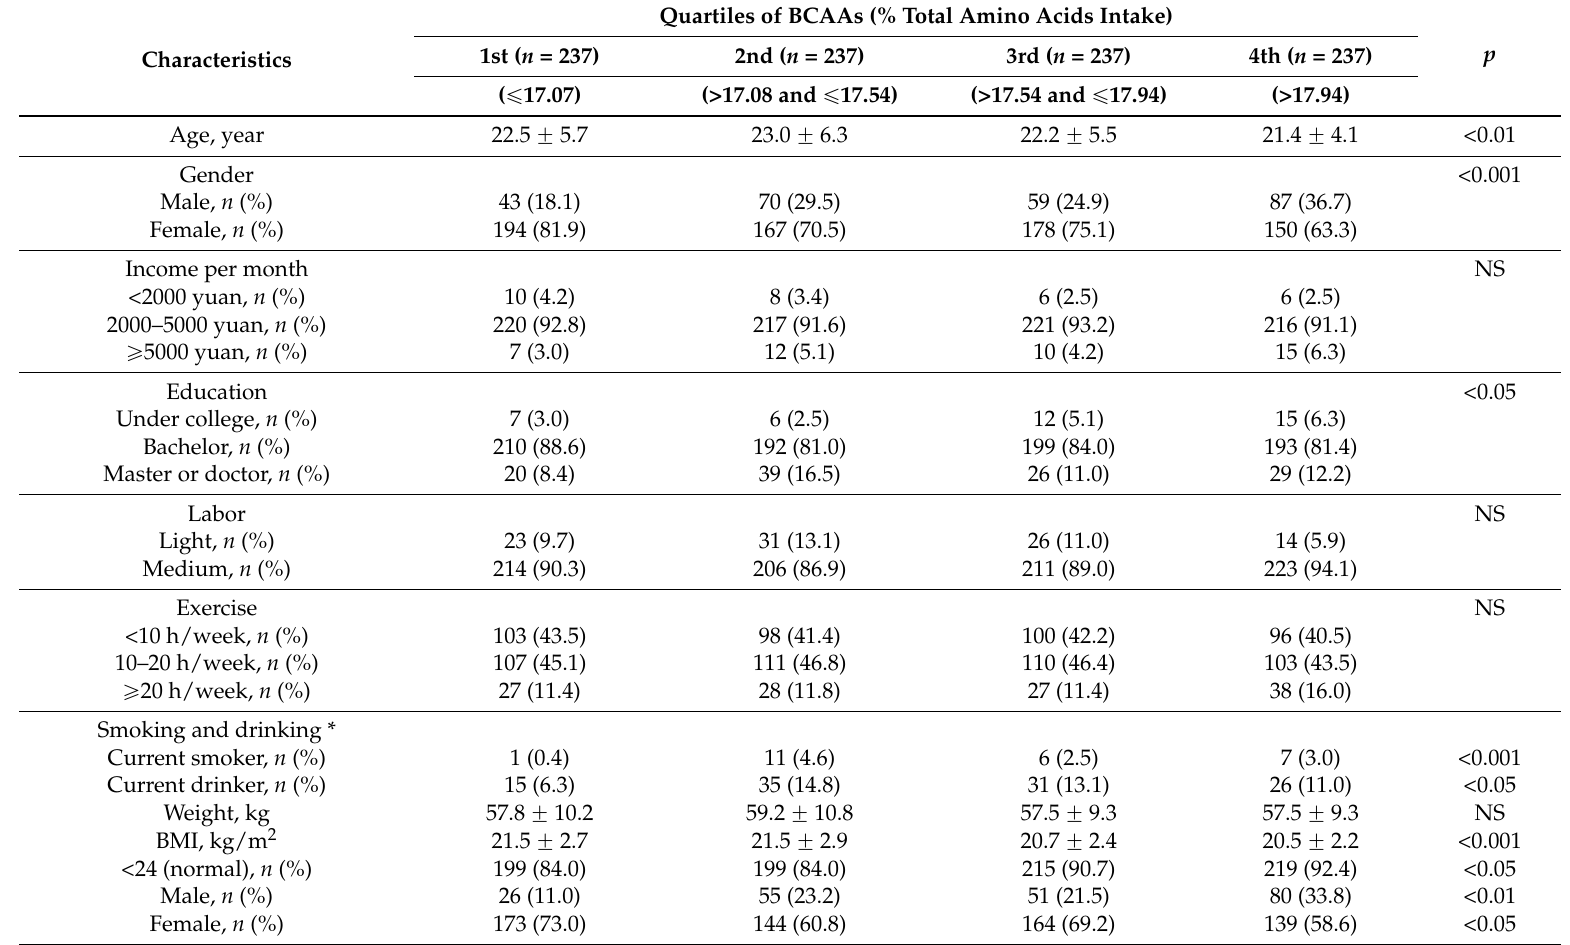
Table 1. Characteristics and dietary intakes of participants by quartile of BCAAs